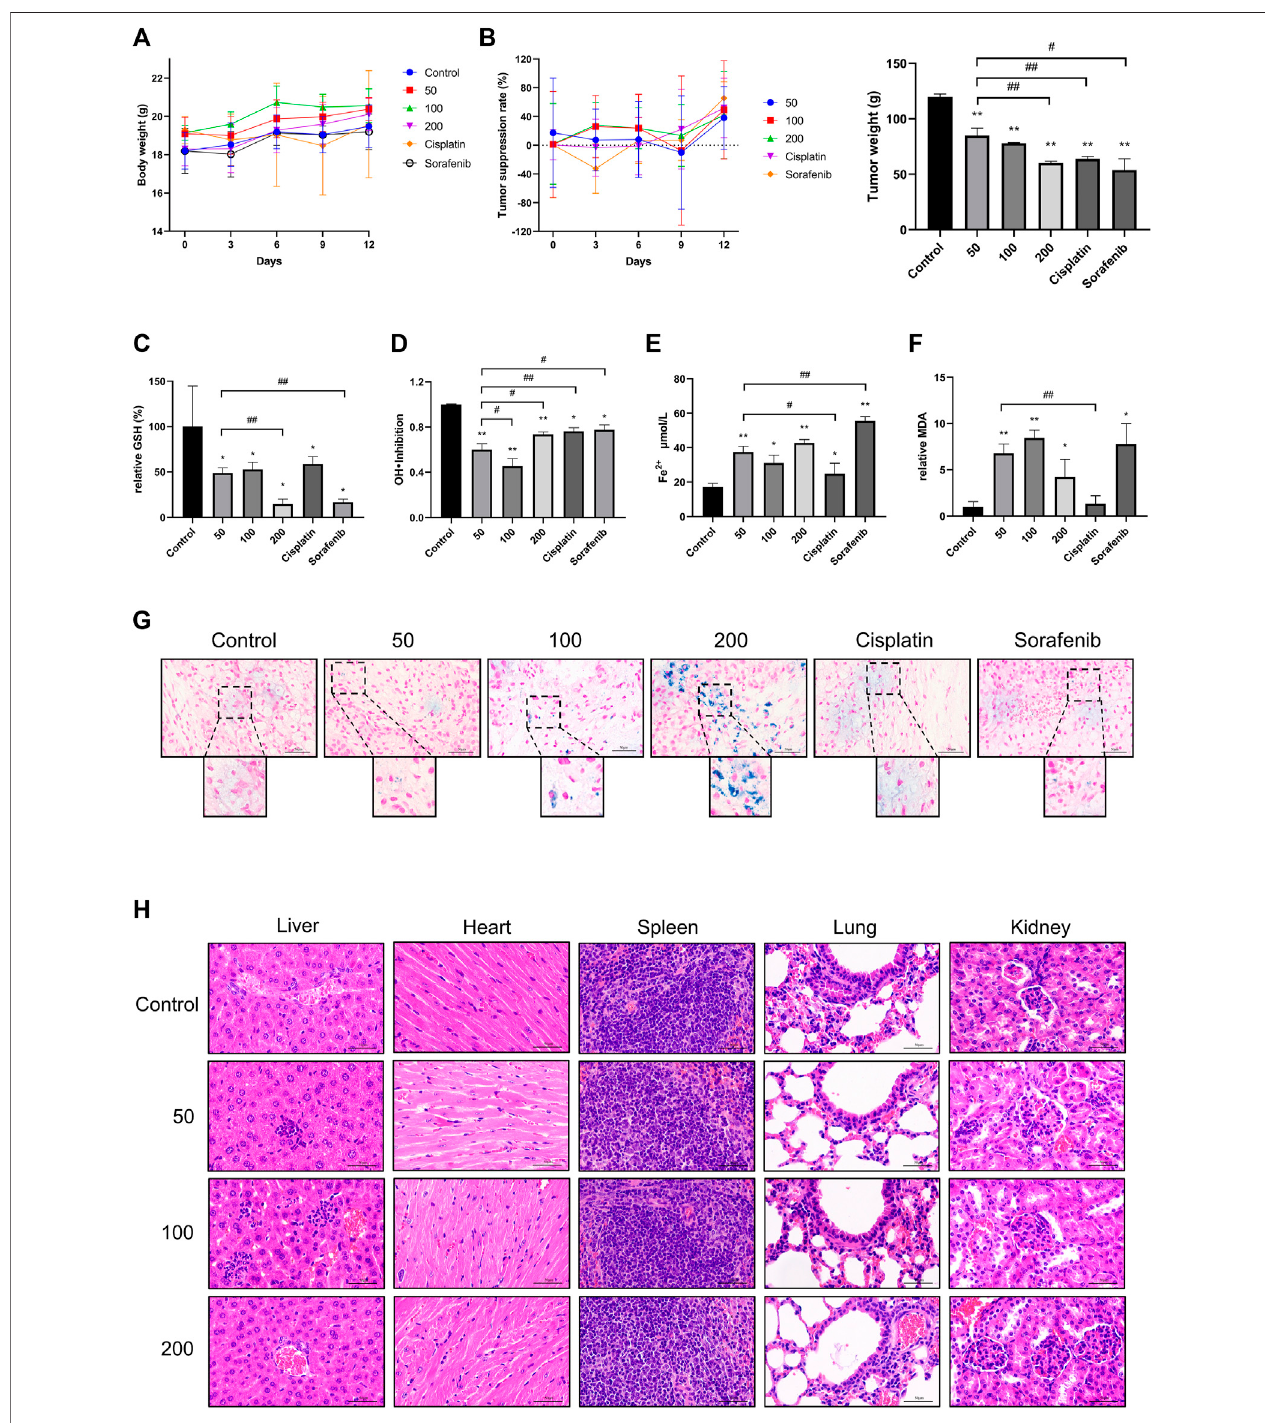
FIGURE7| Effectsofcaryophylleneoxideontumortissueofhepatocellularcarcinoma invivo . (A) Thebodyweightofmicewasmeasuredevery3 days, (B) andthe lengthandwidthofthetransplanted tumor were measured fi vetimes withaVerniercaliper. Theaveragetumor inhibition ratewascalculatedasfollows: (1-tumorvolume of thetreatmentgroup/controltumor volume) ×100%. Attheend oftheexperiment, serum wascollected totest the inhibitory abilityof (C) GSH and (D) hydroxylradical inhibition and (E) Fe 2+ and (F) MDA lipid peroxidation. (G) Prussian blue staining was used to detect ferritinophagy in tumor tissues. (H) HE staining was applied to detect pathological alterations in the liver, heart, spleen, lung, and kidney of nude mice produced by caryophyllene oxide. The ruler has a scale of 50 μ m. The data represented three different experiments (n = 3). The data were presented as mean ± SD. * p < 0.05, ** p < 0.01 when compared to the control group. # p < 0.05, ## p < 0.01 when compared to the 50 mg/kg